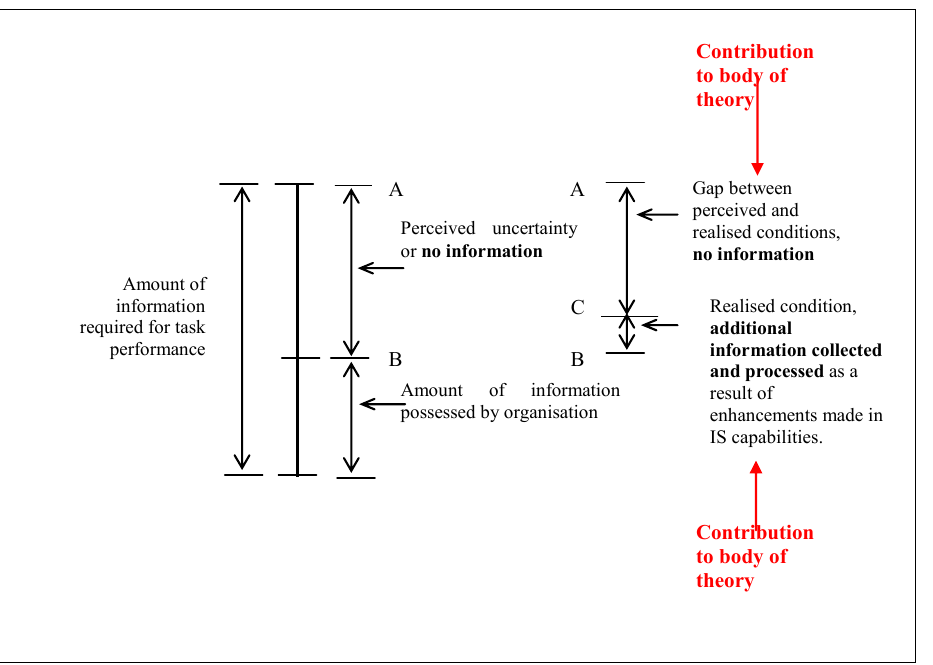
Figure 11: Gap between perceived and realised conditions showing contribution to body of